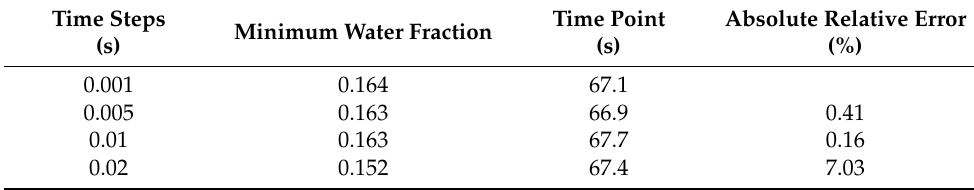
Table 3. Time-step independent analysis of the horizontal